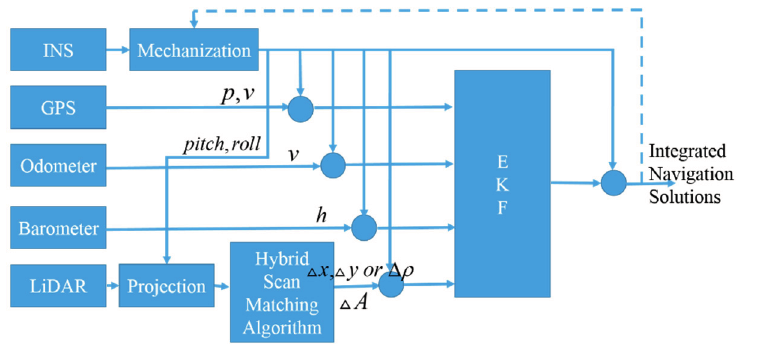
Figure 2. The block diagram of the multi-sensor integrated navigation